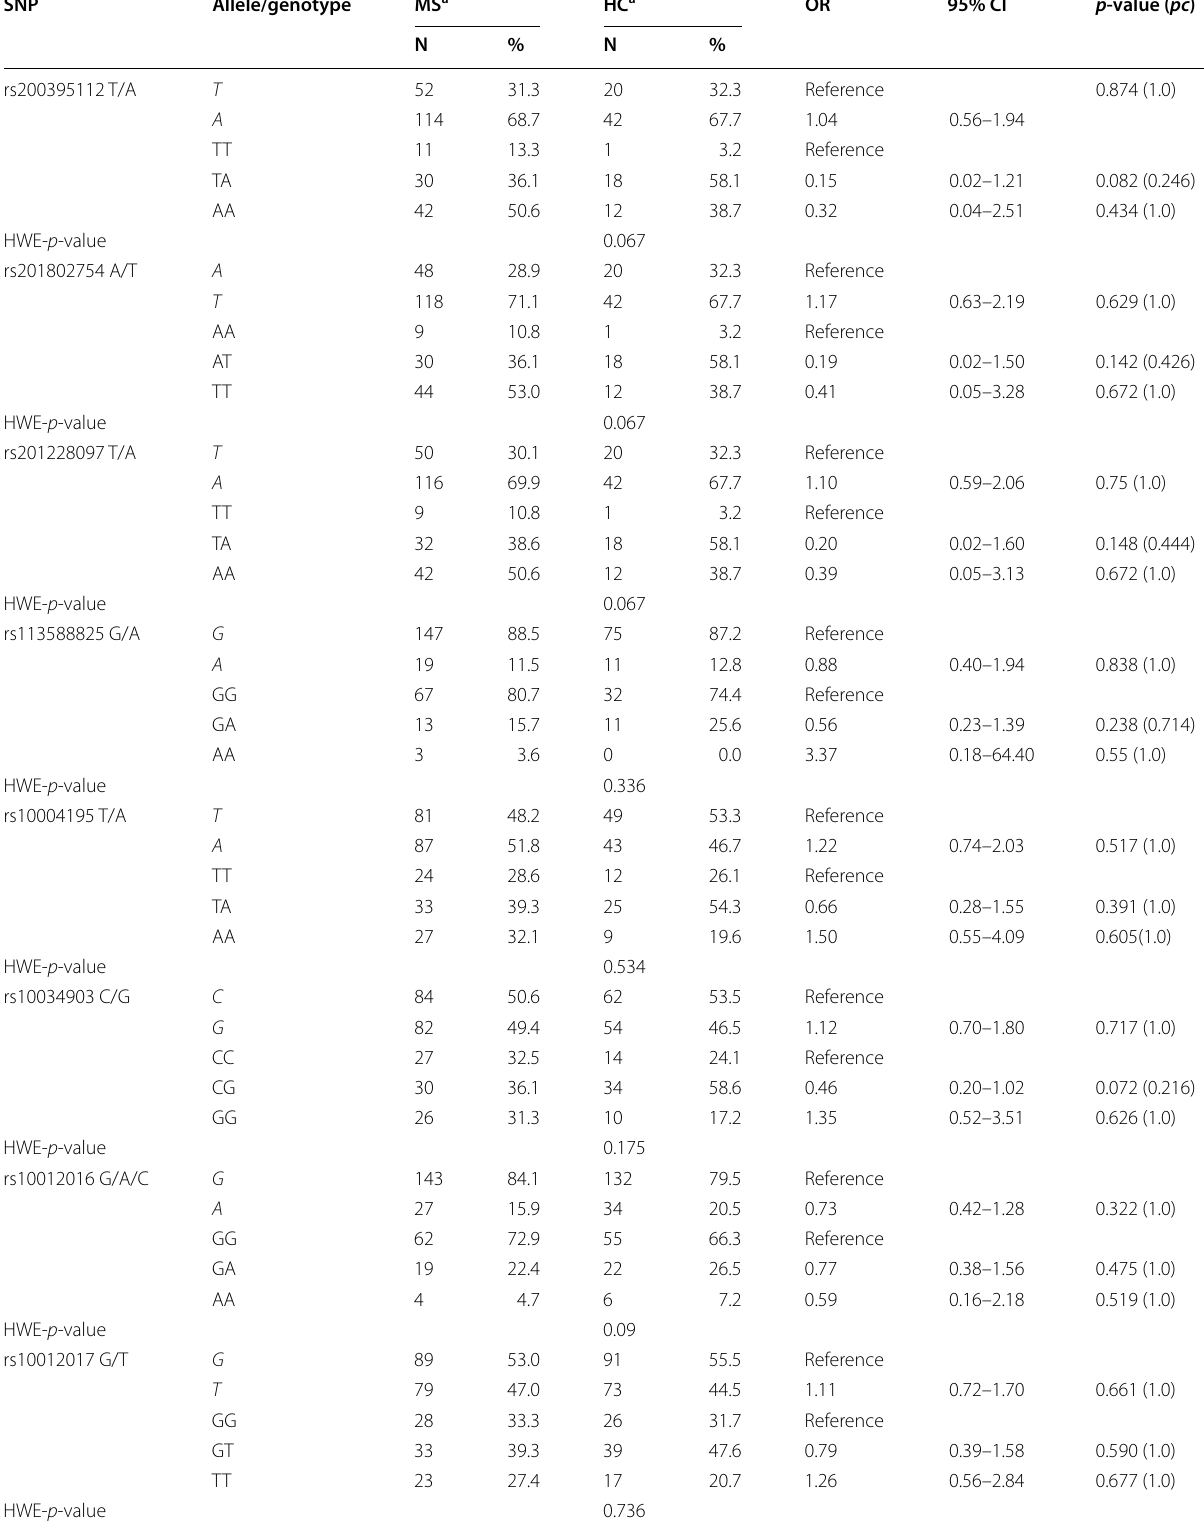
Table 1 Logistic regression and Hardy–Weinberg analyses of TLR10 gene SNPs in multiple sclerosis patients and healthy controls